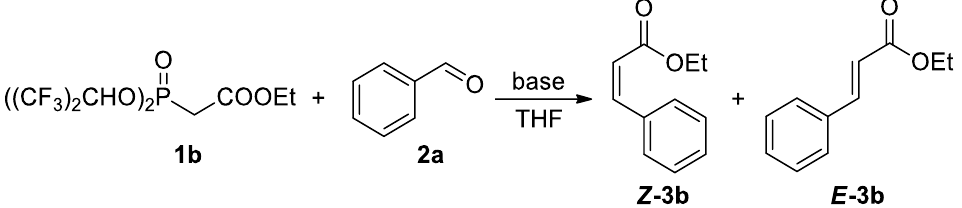
Table 1. Reaction of 1b with benzaldehyde 2a — optimization [a]